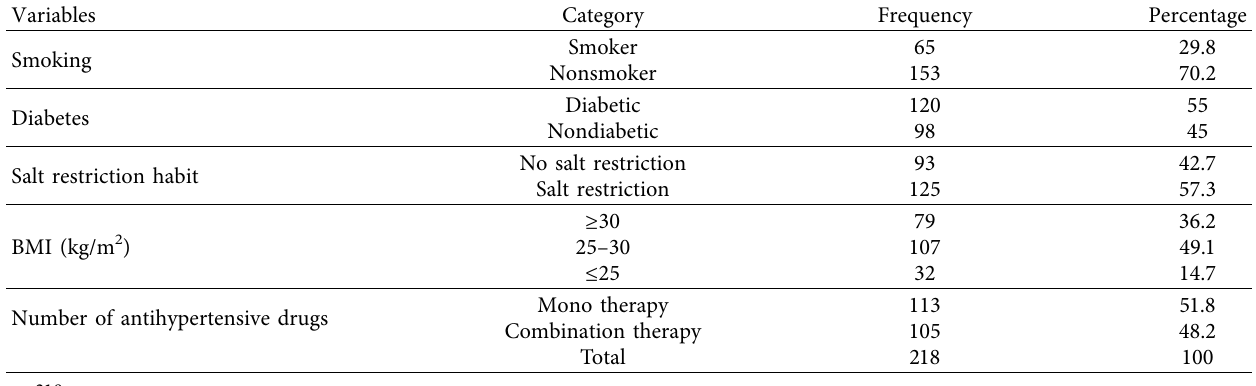
Table 2: Medical and health characteristics of the study sample.